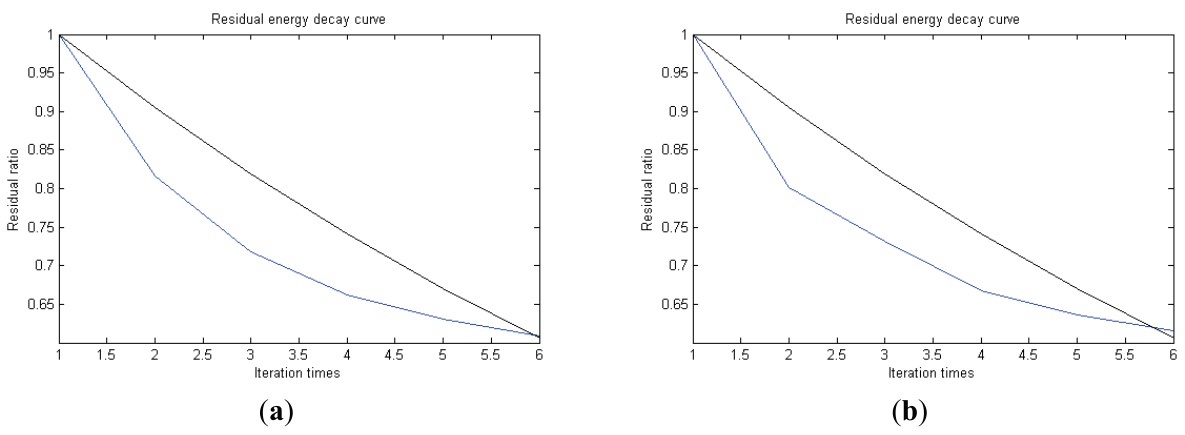
Figure 13. Residual energy decay curve: ( a ) first 512 points; ( b ) last 512